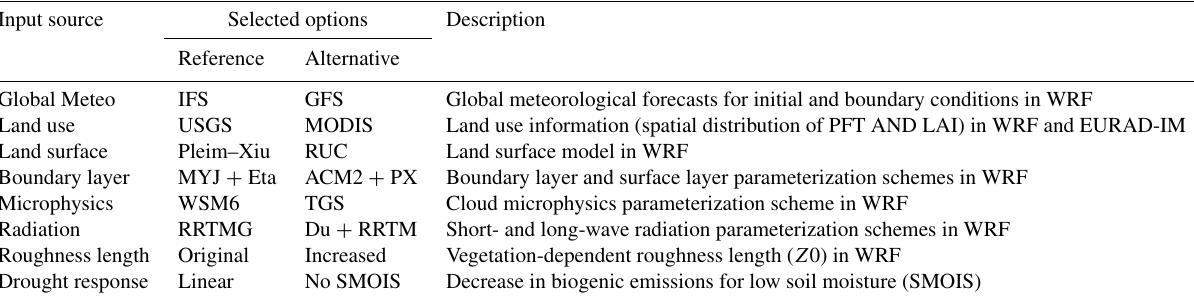
Table 1. Selection and description of considered model input sources. PX signifies Pleim–Xiu surface layer parameterization, and Du signifies Dudhia short-wave radiation parameterization. For further information on parameterization schemes in WRF, see, e.g., Skamarock et al. (2008). Increased roughness lengths are based on Berndt